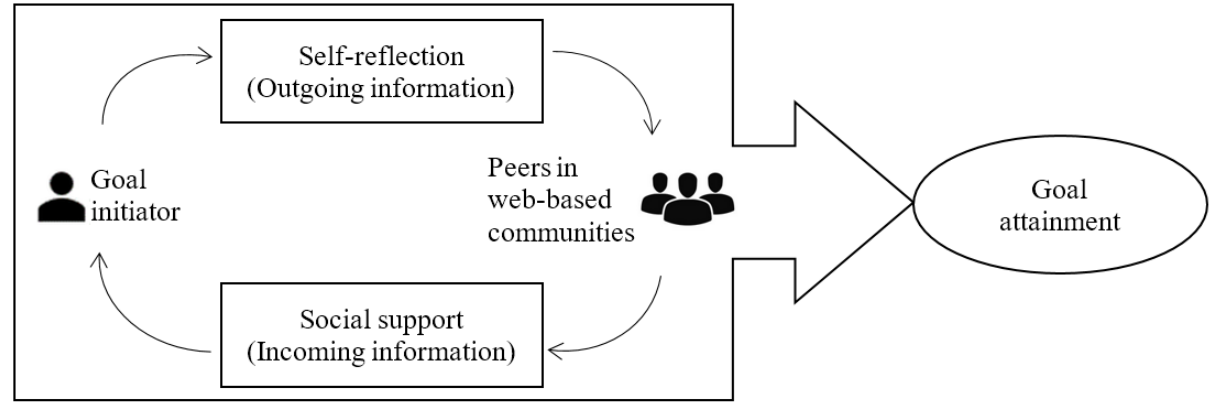
Figure 1. Self-reflection and social support driving goal attainment in web-based patient communities.